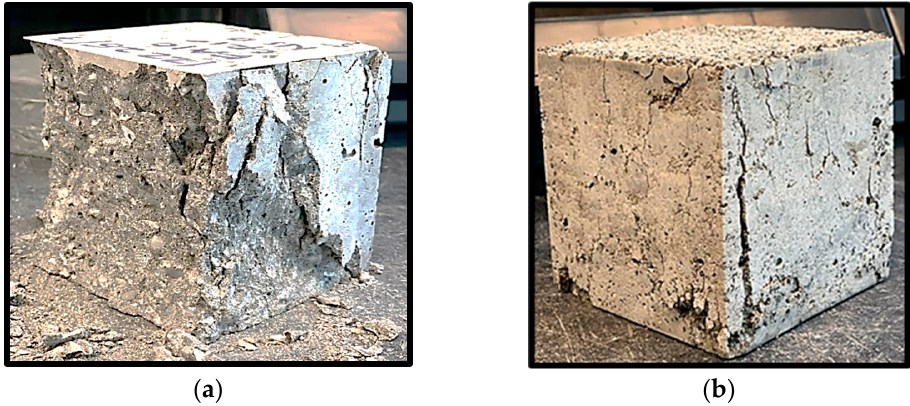
Figure 7. ( a ) FA40CR0NS4 sample at failure; ( b ) FA40CR15NS4 sample at